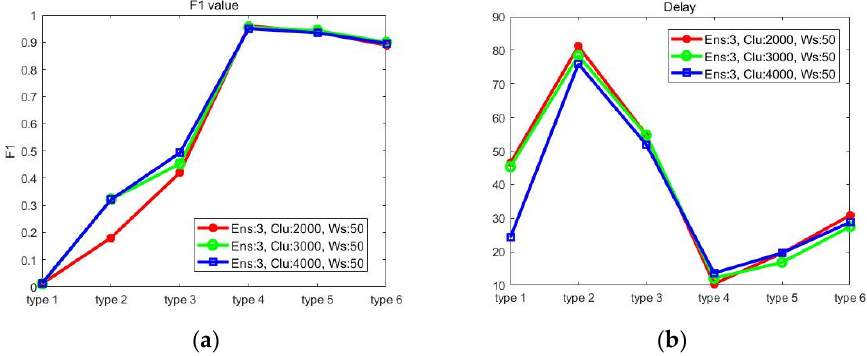
Figure 4. The performance comparison when the number of clusters is set to 2000, 3000, 4000. The number of ensemble members and the window size were fixed to 3 and 50. ( a ) Comparison of F1 value ( b ) Comparison of Delay